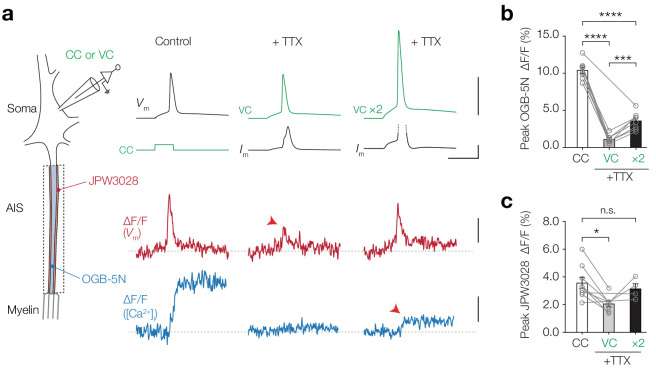
AP-evoked [Ca2+]i changes are TTX sensitive.(a) Left, schematic of the experimental setup; electrophysiological recording from the soma and fluorescence recording from AIS. Right, example traces from electrophysiology (recorded traces in black, applied commands in green), ∆F/F JPW3028 (red) for voltage imaging and ∆F/F OGB-5N (blue) for Ca2+ imaging. Left panel shows example traces from a current clamp recording, middle panel was performed in AP-clamp in the presence of TTX (1 µM) and right panel was performed in AP-clamp scaled two-fold (VC ×2) in the presence of TTX. The JPW3028 and OGB-5N experiments were performed in separate cells. Scale bars from top to bottom, 100 mV, 5 nA, 5 ms, 2% ∆F/F and 5% ∆F/F. (b) Peak OGB-5N ΔF/F in response to an AP (n = 8), AP clamp + TTX (VC, n = 7) and double AP clamp + TTX (VC ×2, n = 8). One-way ANOVA with Tukey’s multiple comparisons test, ***p=0.0005, ****p<0.0001, n = 8. Circles and connecting lines represent paired recordings in individual cells and bars show the population mean ± s.e.m. (c) Peak JPW3028 ΔF/F in response to an AP (n = 9), AP clamp + TTX (VC, n = 7) and double AP clamp + TTX (VC ×2, n = 4). One-way ANOVA with Tukey’s multiple comparisons test, *p=0.014. Circles and connecting lines represent paired recordings in individual cells and bars show the population mean ± s.e.m. Data available in Figure 5—source data 1. See also Figure 5—figure supplement 1.Figure 5—source data 1.AP-evoked [Ca2+]i changes are TTX sensitive.